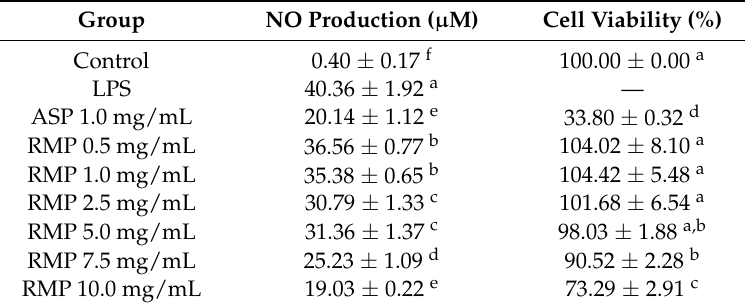
Table 4. Anti-inflammatory activity of